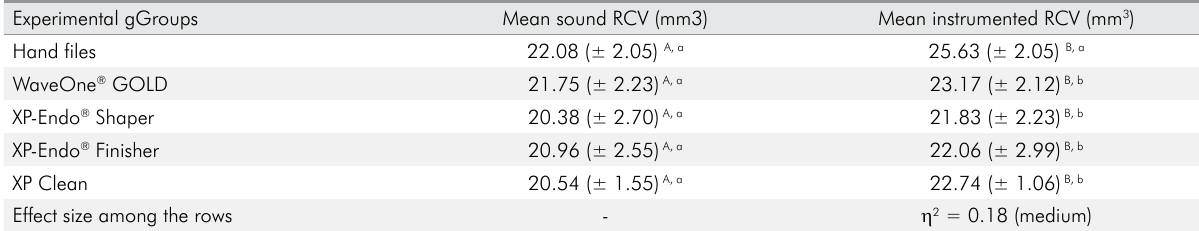
Table 1. Mean (±SD) sound and instrumented root canal volume (RCV) among the experimental groups. Experimental gGroups